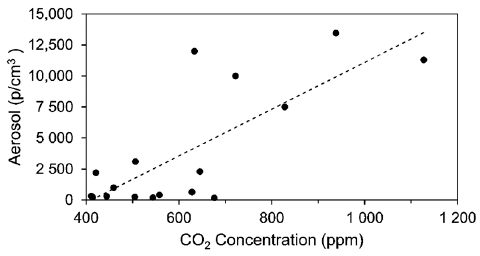
Figure 7. Measured correlation between CO 2 and aerosol dispersion in the concert hall obtained under real conditions. The Pearson correlation coefficient is r = 0.77.